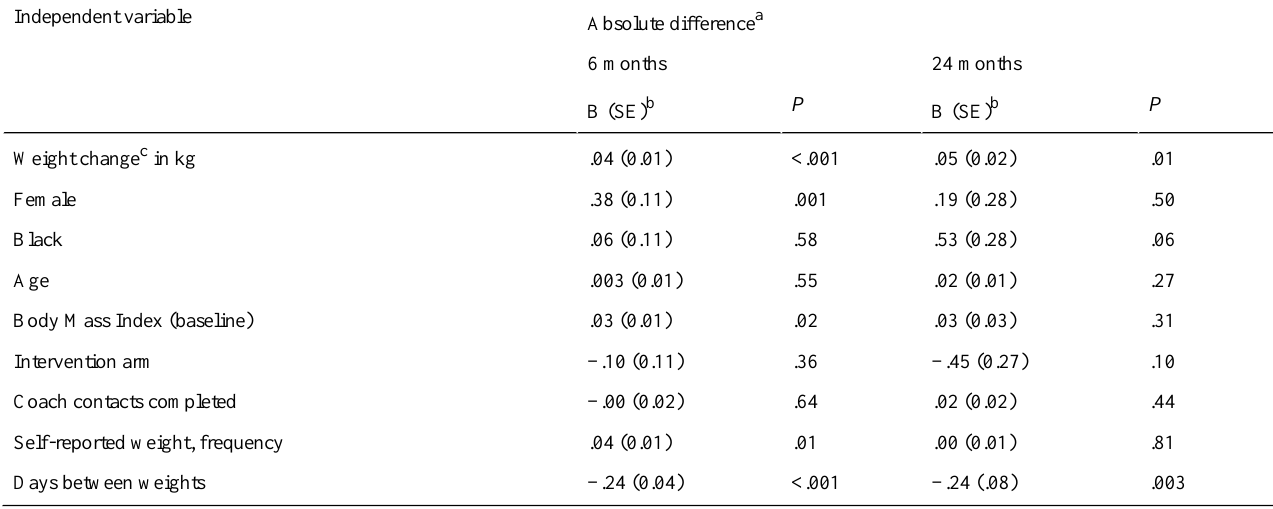
Table 2. Association of absolute difference in weights (self-reported – clinic) with weight change, demographic characteristics, and participation at 6 and 24 months.